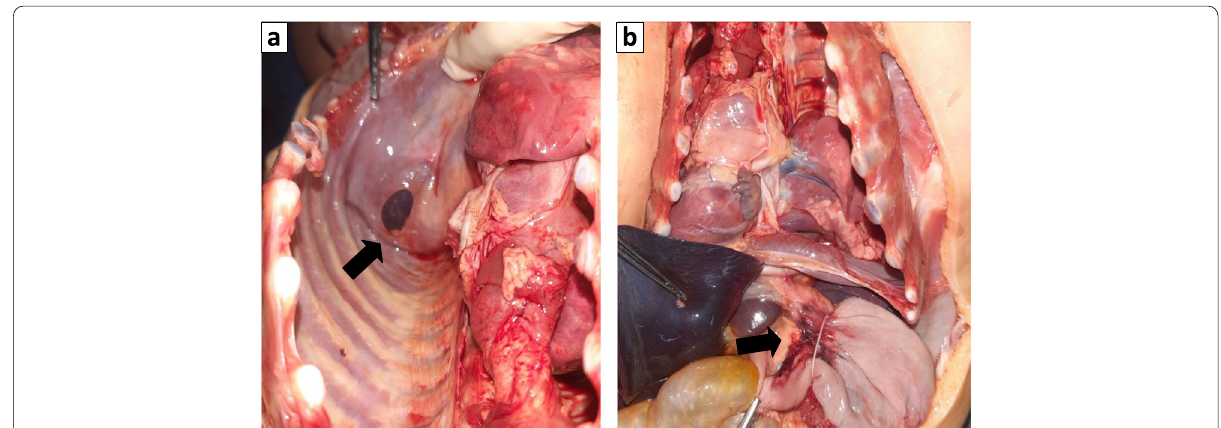
Fig. 2 a Autopsy findings showing the diaphragm defect (arrow) and ecchymotic stomach portion (lesser curvature) entrapped in the hernia defect ( b ) (arrow)